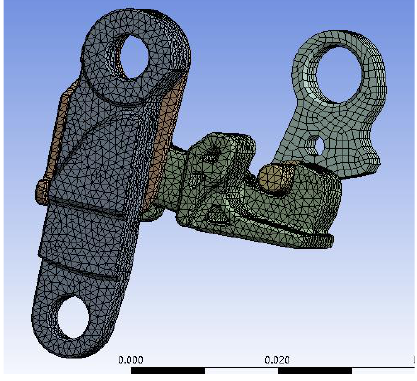
Figure 12. Simulation model meshing results.